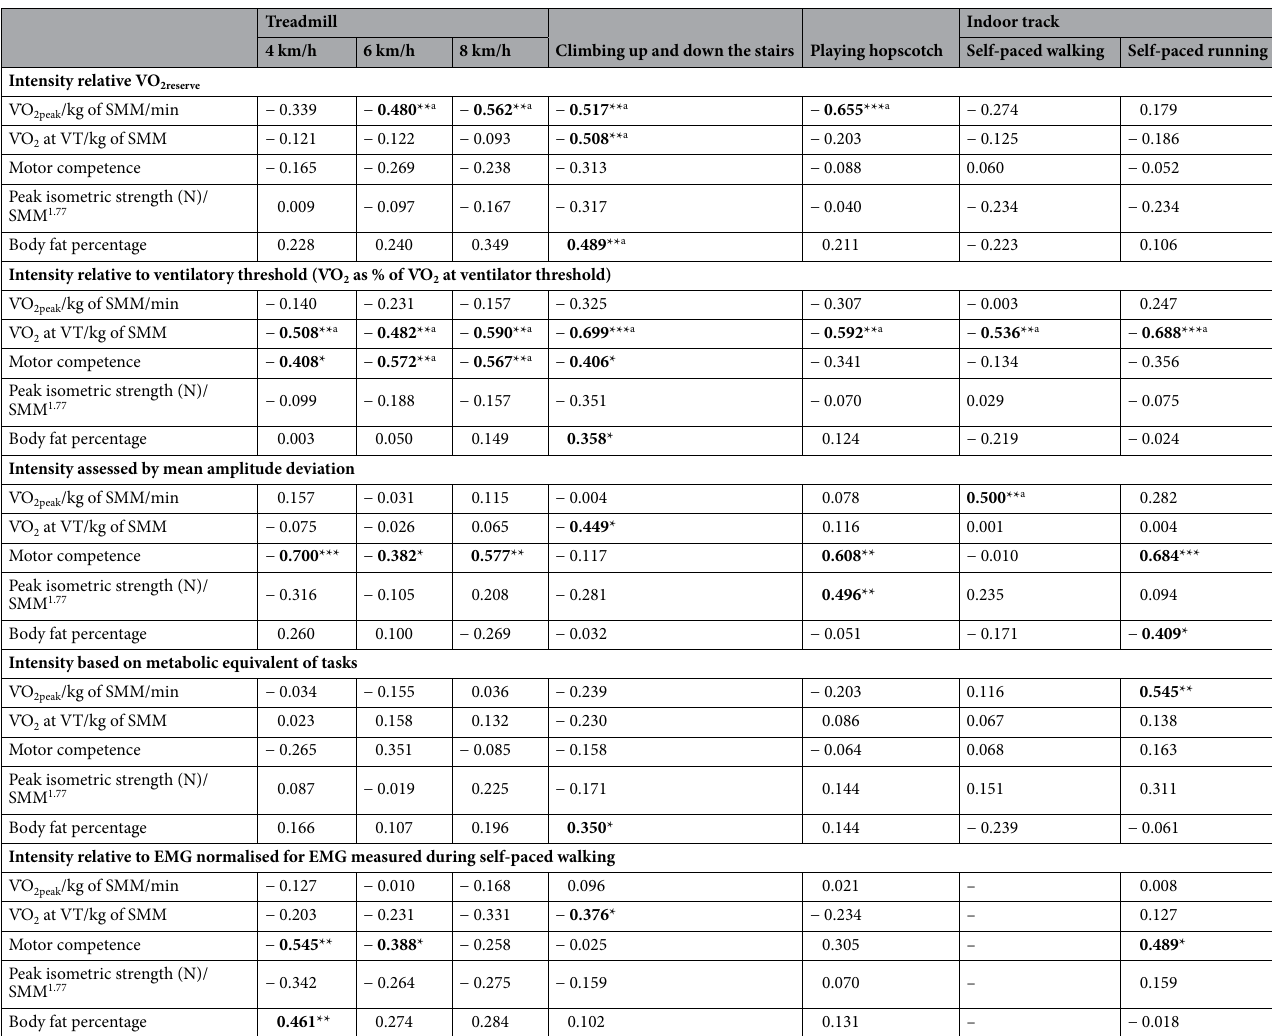
Table 3. Spearman correlations coefficients of cardiorespiratory fitness, motor competence, muscle strength, and adiposity to physical activity intensity in different tasks. V ̇ O 2peak /kg of SMM/min = peak oxygen uptake scaled by skeletal muscle mass (SMM); V ̇ O 2 at VT/kg of SMM = oxygen uptake at ventilatory threshold scaled by skeletal muscle mass; N = Newtons. * p < 0.05, ** p < 0.01, *** p < 0.001. Table includes both non-corrected and corrected significances. Statistically significant non-corrected associations are given in bold. a Statistically significant after the Bonferroni